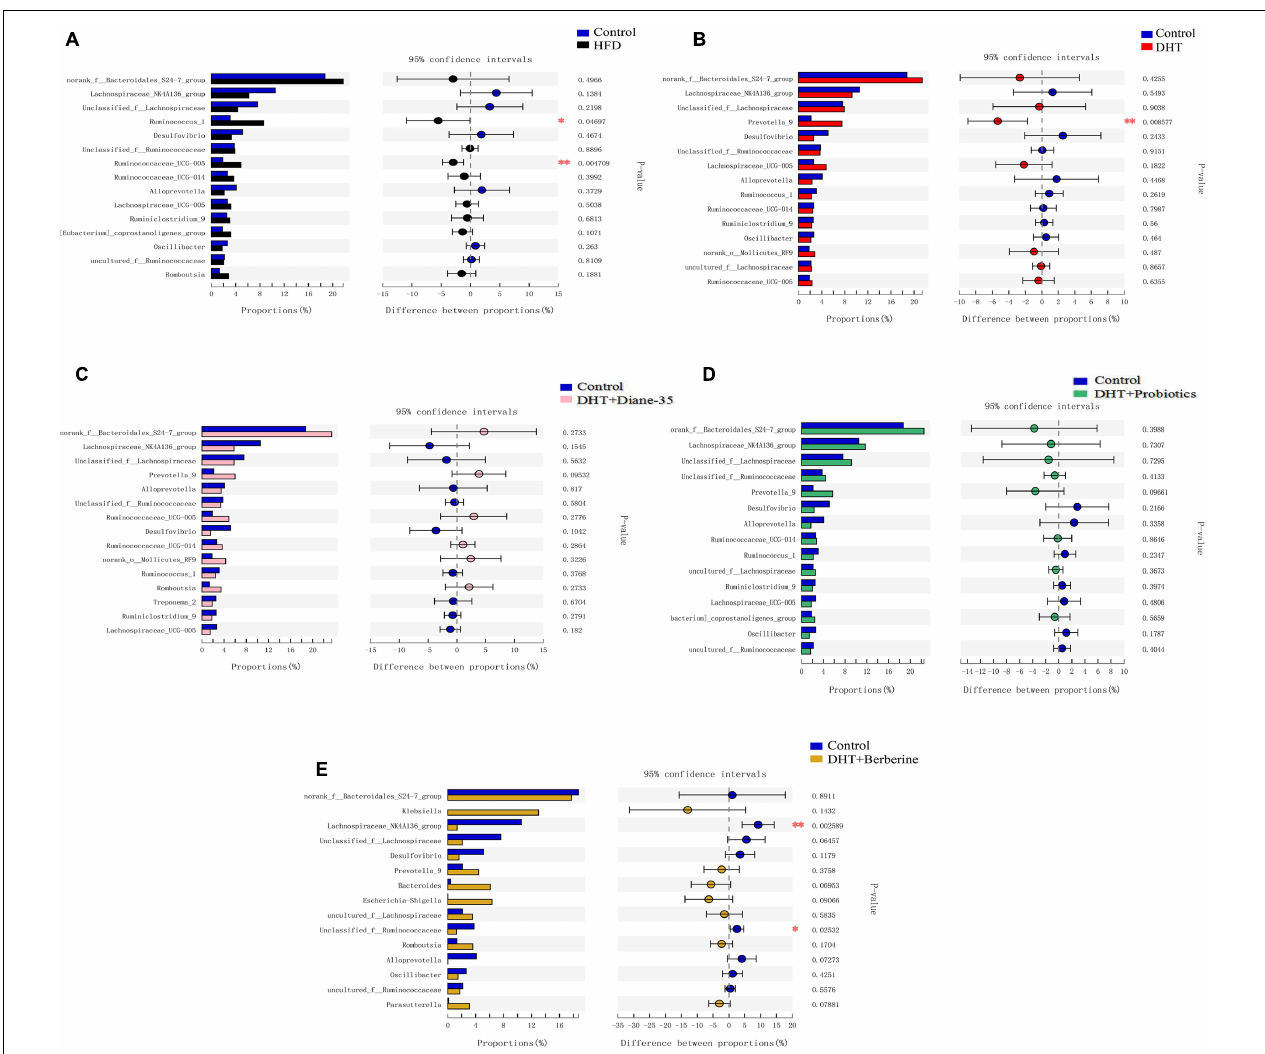
FIGURE 6 | Different fecal microbiota in rats at the genus level. The histograms on the left represent the means of relative abundance of different microbiota in the group, and the right side shows the p -values and the 95% confidence intervals of the difference between groups. Statistical significance was defined as p < 0.05 using Student’s t -test. (A) The Ruminococcus_1 , and Ruminococcaceae_UCG-005 were significantly increased in the HFD group compared to control. (B) The Prevotella_9 was decreased in the DHT group compared to control. (C,D) The different genera were similar between the control and the DHT + Diane-35 and DHT + Probiotics group. (E) Lachnospiraceae_NK4A136_group , Unclassified_f__Ruminococcaceae , were significantly decreased in the DHT + Berberine group compared to control